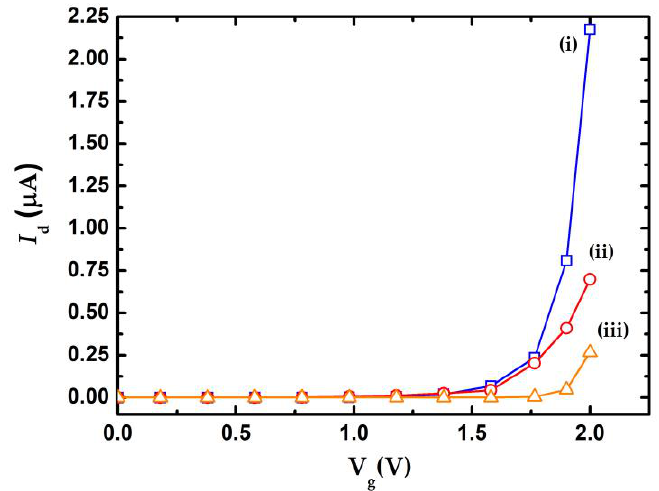
Figure 3. Simulation results of I d -V g curve for various dopant concentrations of the poly-silicon nan- owire.